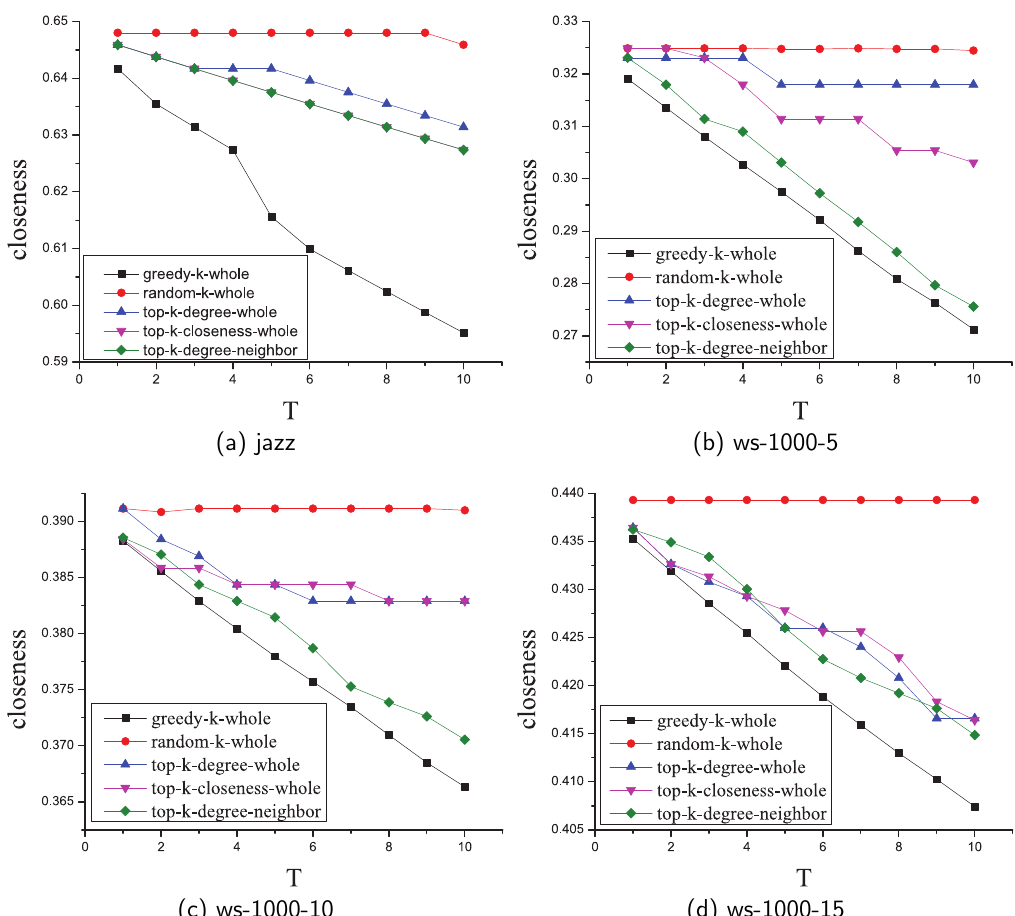
Figure 6. The comparison of the greedy algorithm with the baseline